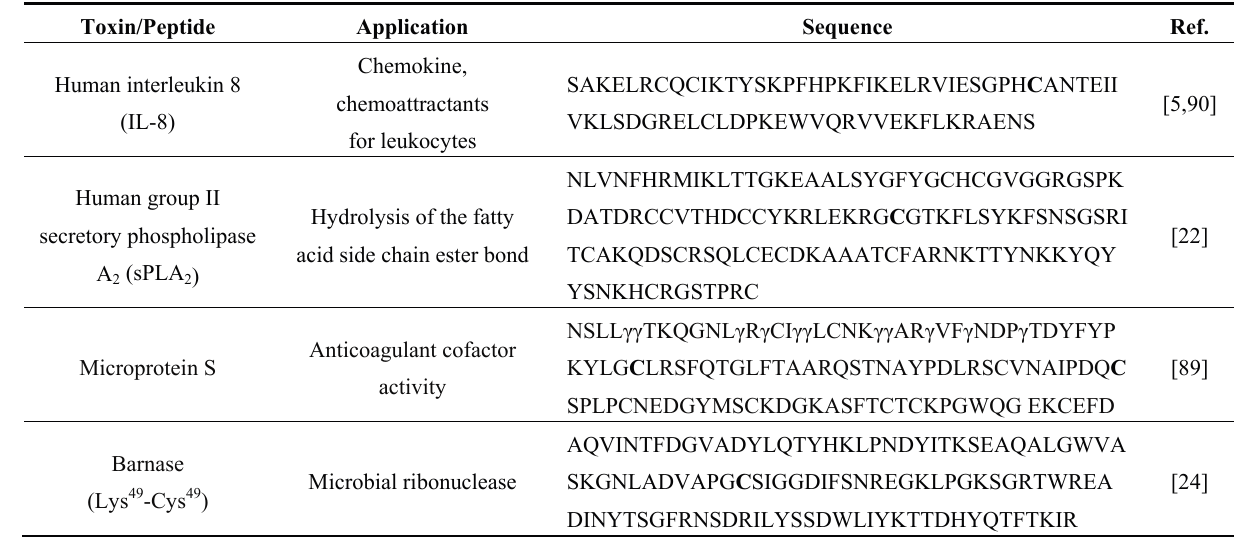
Table 2. Examples of the application of NCL to circumvent peptide size limitation. Cysteine residues used as ligation sites are in bold and larger font. γ = Gamma carboxyglutamic